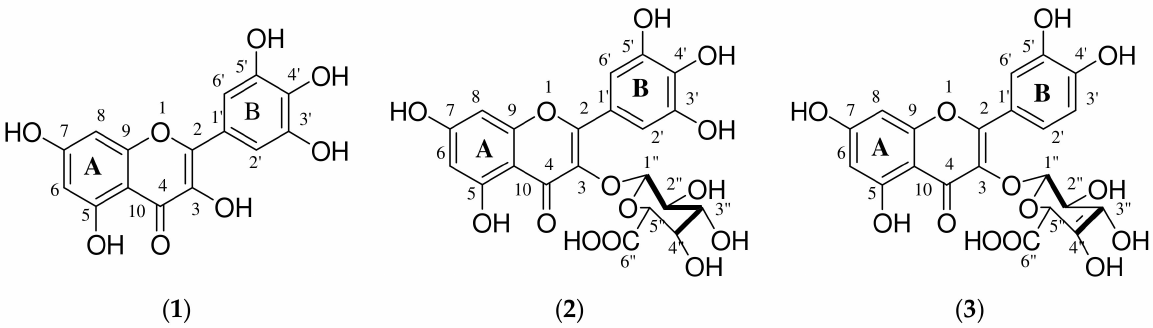
Figure 7. Chemical structures of isolated compounds; myricetin ( 1 ), myricetin-3-O- β -D-glucuronide ( 2 ) and quercetin-3-O- β -D-glucuronide ( 3